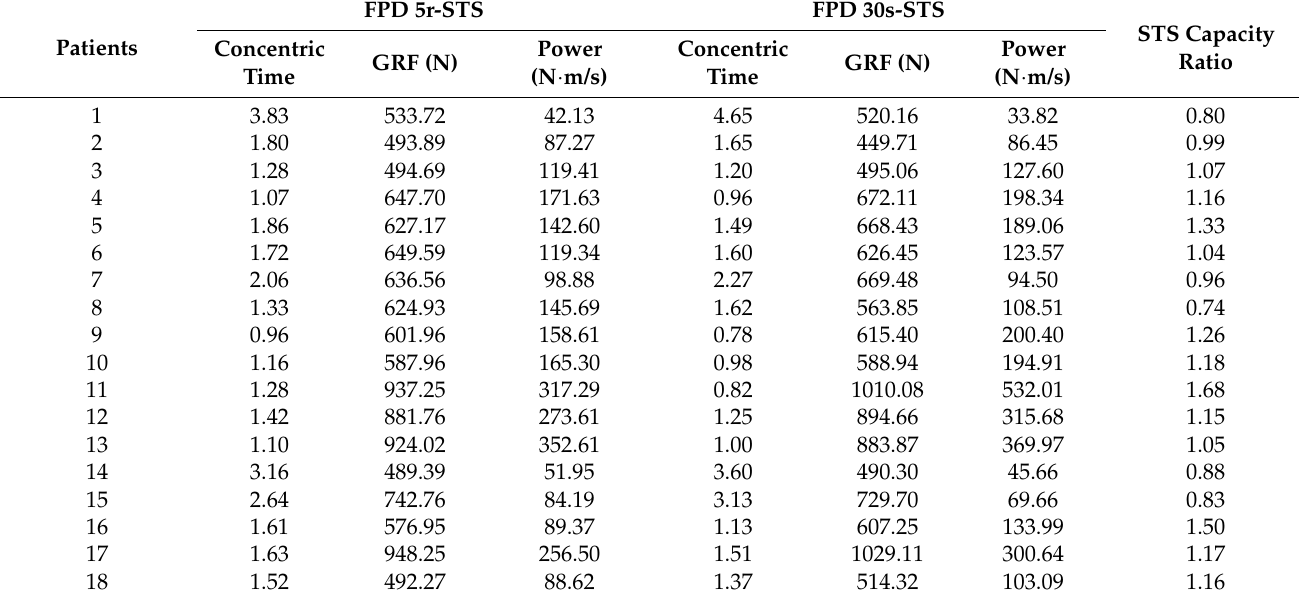
NOTE. Values are raw data of all participants. FPD, force plate-derived; STS, sit to stand; GRF, ground reaction forces.